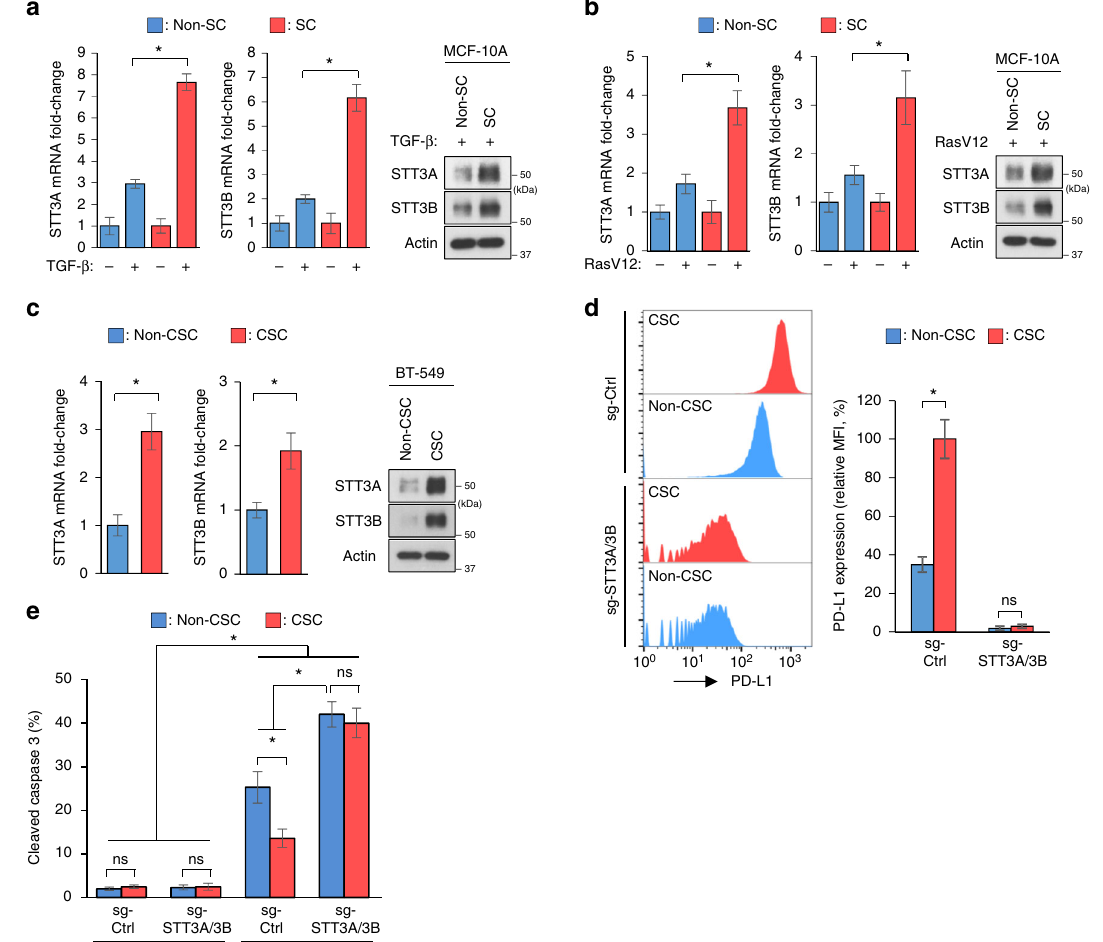
Fig. 3 EMT induces higher levels of STT3 in CSCs than in non-CSCs, resulting in enriched PD-L1 in CSCs. a , b qRT-PCR and western blot analyses of STT3 induction in SCs (CD44 + CD24 − /low populations) and non-SCs (non-CD44 + CD24 − /low populations) of MCF-10A after TGF- β ( a ) or RasV12 ( b ) treatment. c qRT-PCR and western blot analyses of intrinsic STT3 expression in CSCs (CD44 + CD24 − /low populations) and non-CSCs (non-CD44 + CD24 − /low populations) of BT-549 cells. d Flow cytometric analysis of the effect of STT3A/3B knockdown on PD-L1 expression in CSCs and non-CSCs. e Ef fi cacy of STT3A/3B knockdown in sensitizing CSCs to PBMC-mediated cancer cell killing. Error bars represent s.d. ( n = 3). * P < 0.05; ns: non-signi fi